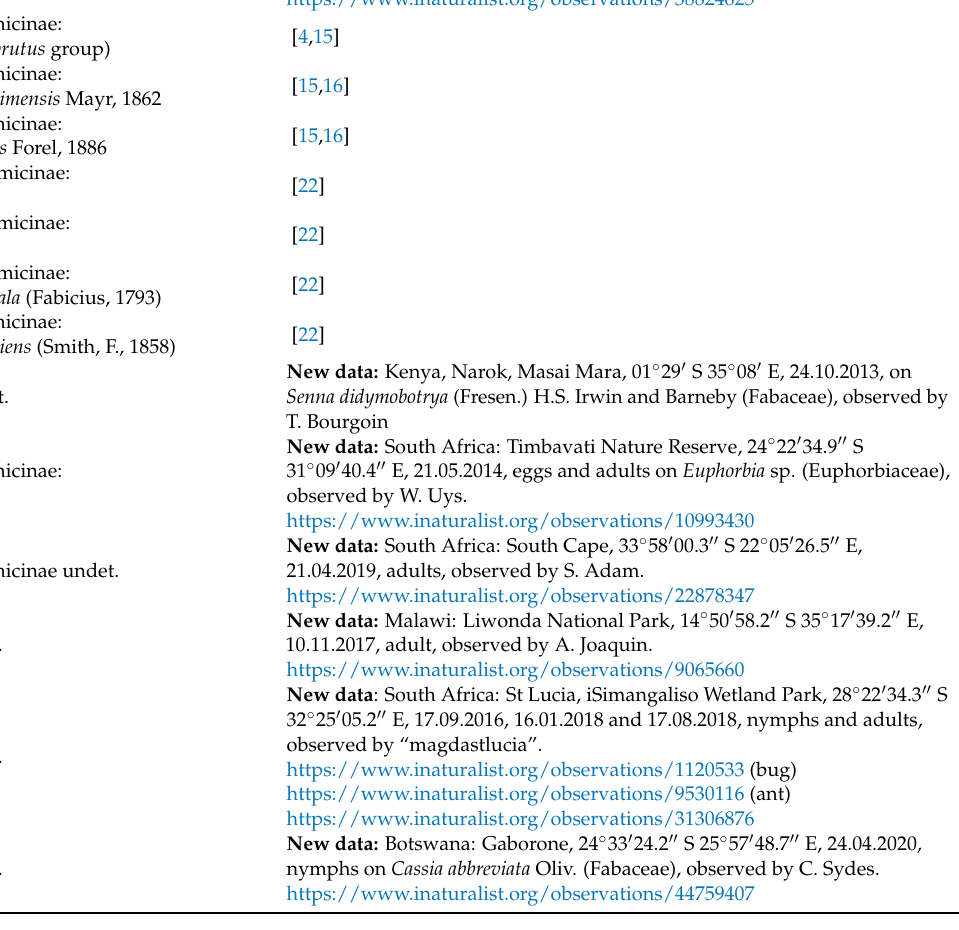
Nototettigometra ( Nototettigometra) Figure 25d patruelis (Stål, 1855)